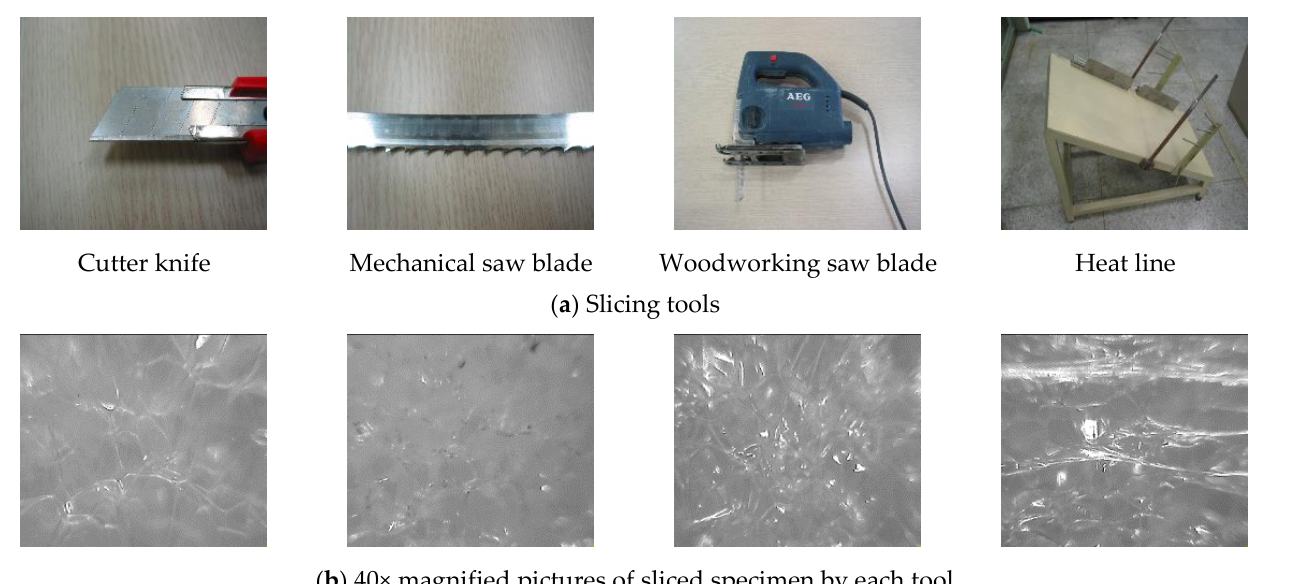
Figure 1. ( a ) Slicing tools; ( b ) 40× magnified cutting cross-section of specimen corresponding above tools.